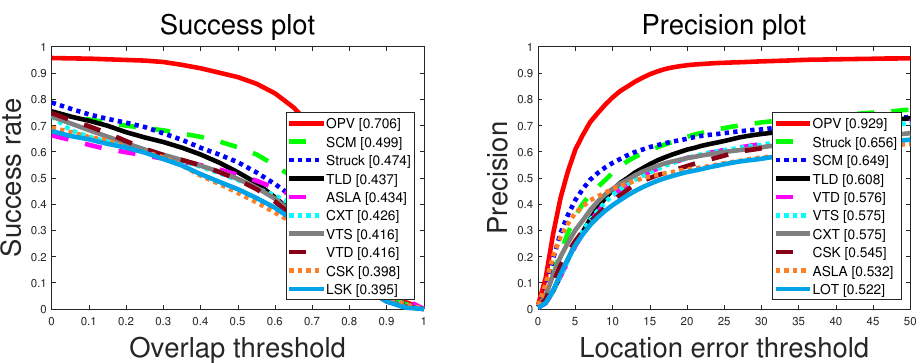
Figure 2. Quantitative comparison on non-deep learning-based methods using the OTB dataset. We compared the proposed method (OPV) with Sparsity-based Collaborative Model (SCM), STRUCtured output tracking with Kernels (Struck), Tracking-Learning-Detection (TLD), Adaptive Structural Local sparse Appearance (ASLA), ConteXt Tracker (CXT), Visual Tracker Sampler (VTS), visual trackibg decomposition (VTD), Circulant Structure of tracking-by-detection with Kernels (CSK), Local Sparse appearance model and K-selection (LSK), and Locally Orderless Tracking